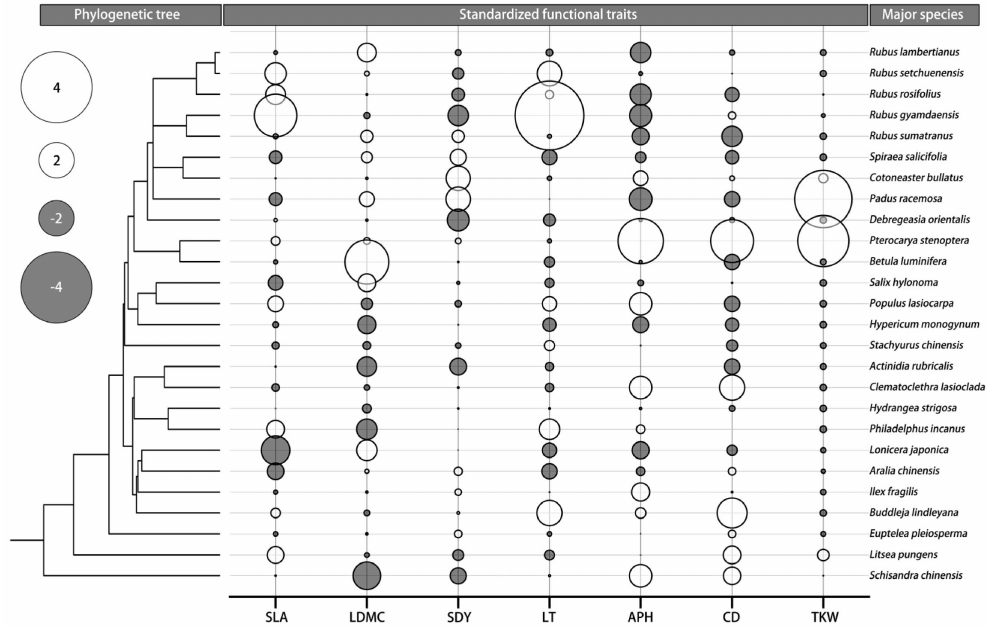
Figure 2. Functional traits at the species scale, linked with phylogenetic relationships, after an earthquake. Phylogenetic trees are shown on the left, species names of major woody plants are shown on the right, and standardized trait values are shown in the middle. These three parts correspond to one another by